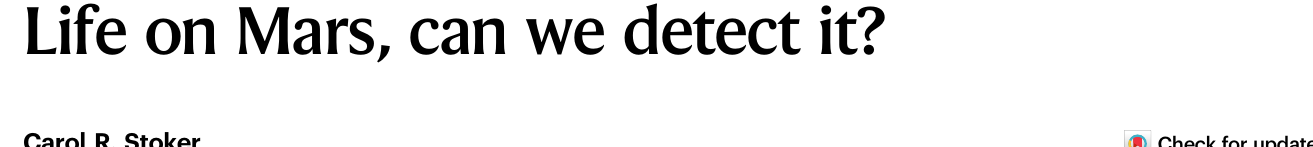
captured by the MastCam-Z camera on the Perseverance Rover in June 2022 15 (Courtesy NASA/JPL-Caltech/ASU/MSSS). The height of both white scale bars are ~2m.